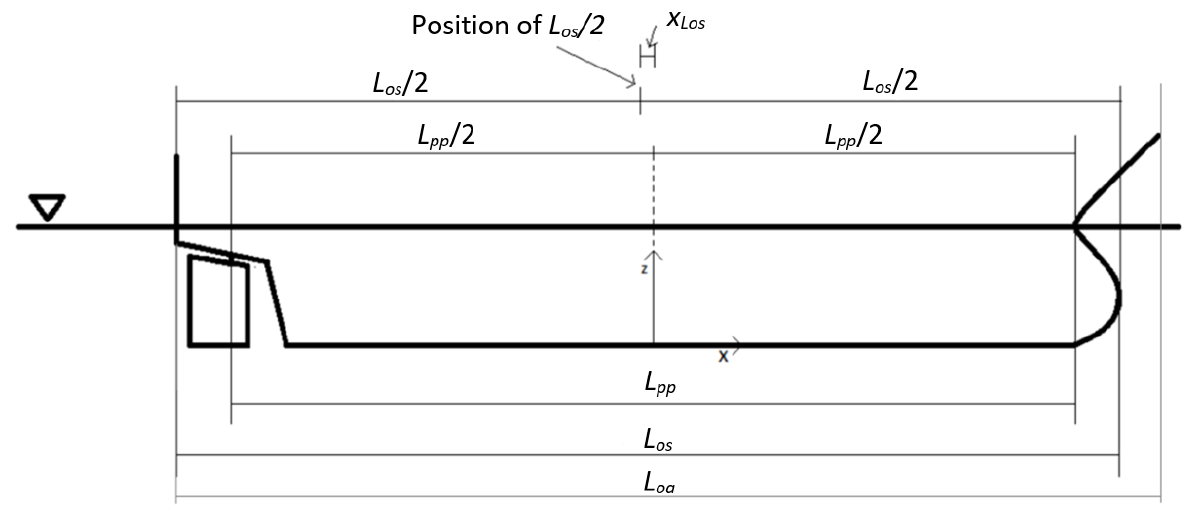
Figure 2. Ship geometrical parameters [22].